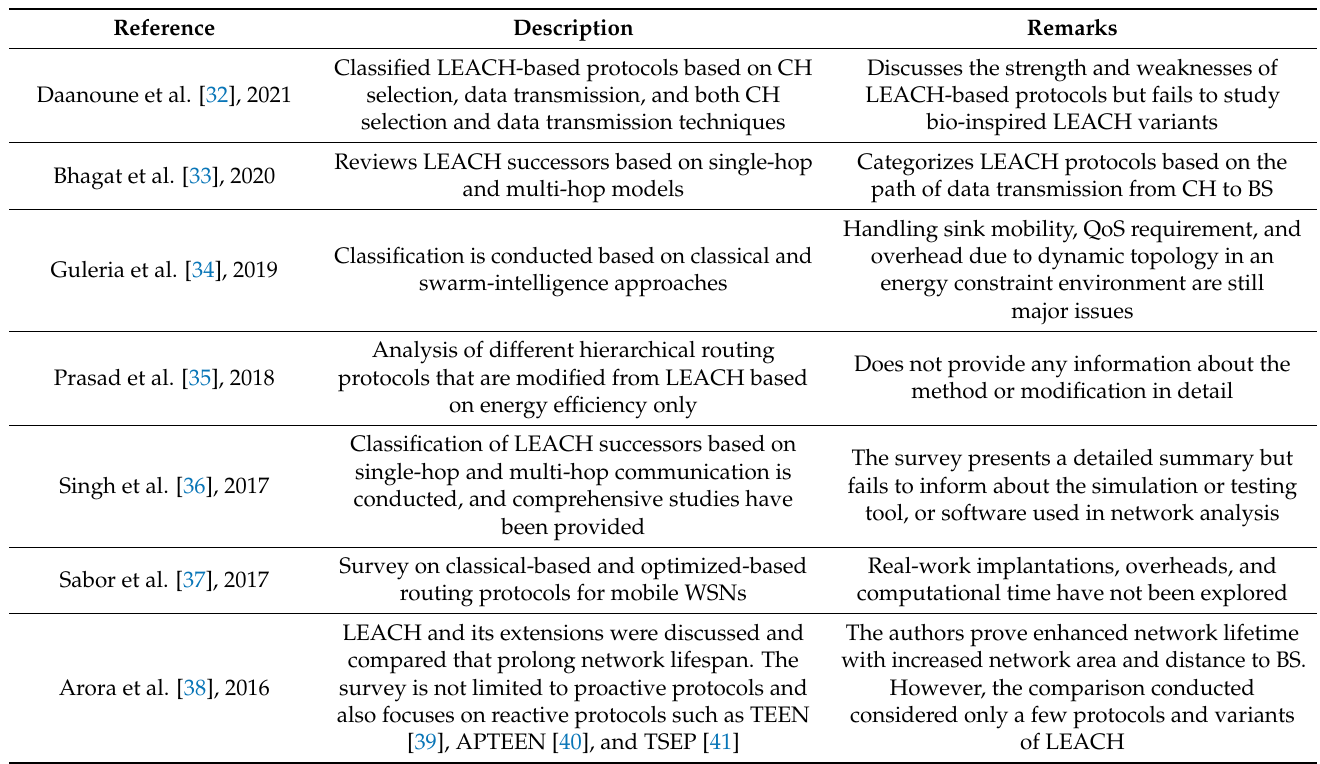
Table 1. Survey on LEACH-based